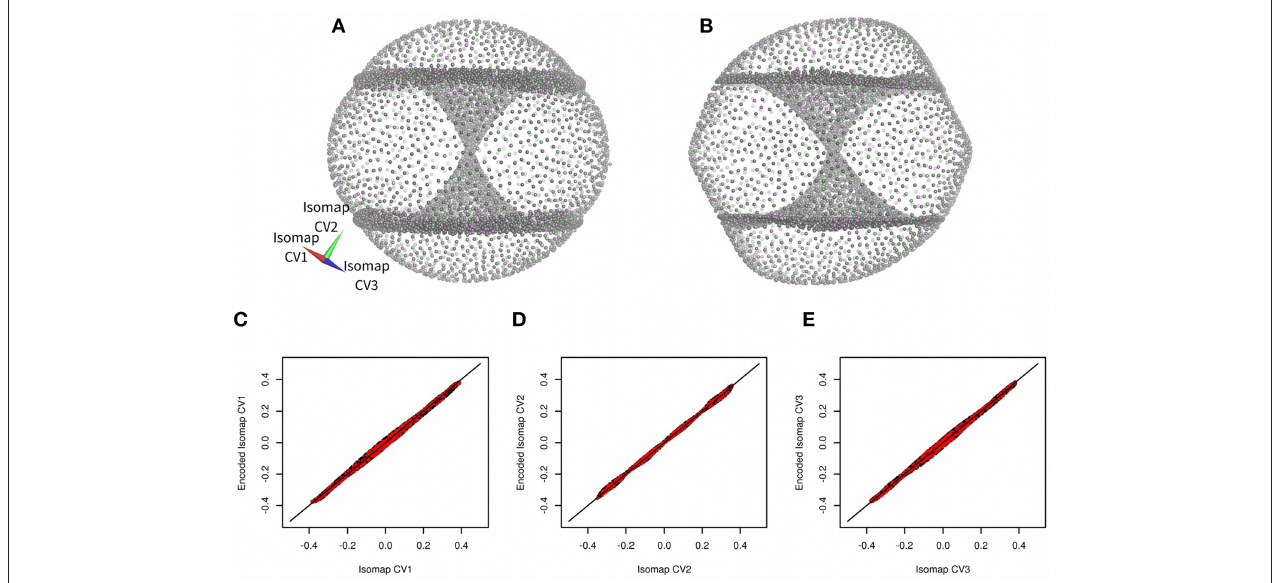
FIGURE 2 | Three-dimensional Isomap embeddings of trans , trans -1,2,4-trifluorocyclooctane (A) and its approximation using anncolvar (B) . Isomap embeddings in (A) and (B) were rotated by angle [0.00rad, 2.40rad, − 0.55rad] for better clarity. Training set points are in gray, test set points are in different colors depending on whether they were used to train Isomap embedding 1, 2, or 3. Comparison of Isomap embeddings 1 (C) , 2 (D), and 3 (E) original (horizontal) vs. approximated by anncolvar (vertical). Training set points are in black, test set points are in red. Distribution of differences between original and predicted CVs can be found in Figure S1